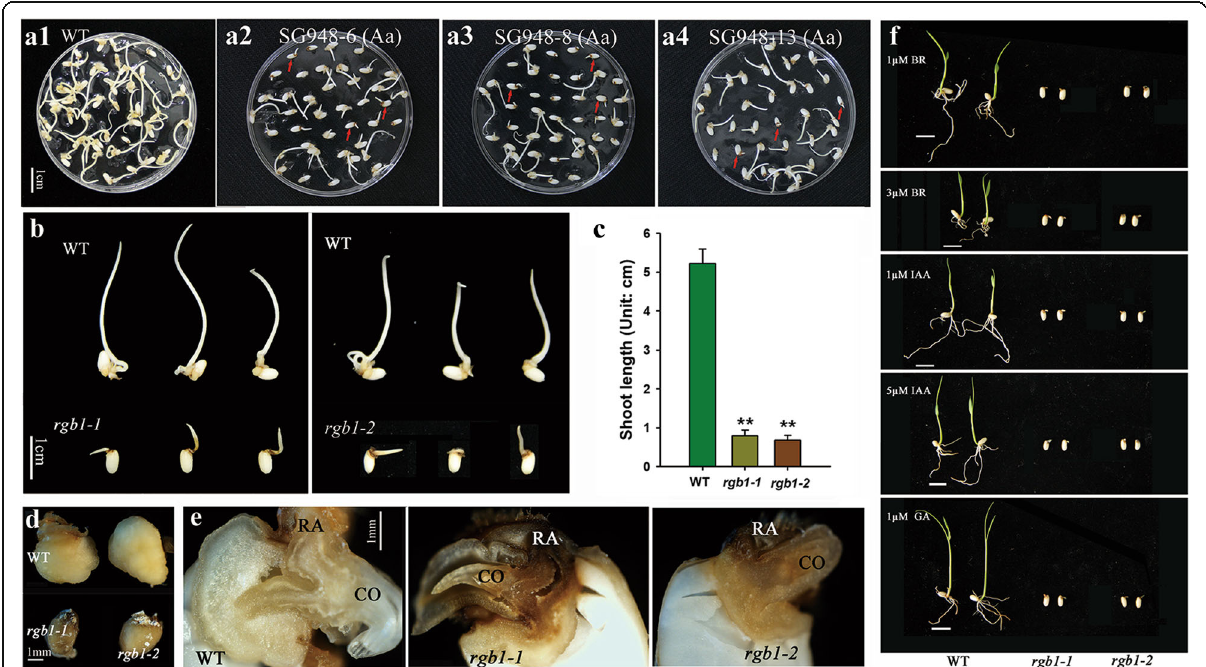
Fig. 3 Callus induction from the mature seeds after 10 days and the different hormone treatments of rgb1 mutants, RGB1 heterozygous mutants, and WT. (a) Mature seeds of the RGB1 heterozygous mutant lines and WT cultured on callus preinduction media (N6D2). (a1) WT control, (a2) SG948 – 6 (Aa), (a3) SG948 – 8 (Aa), (a4) SG948 – 13 (Aa) (Aa indicates heterozygous RGB1/rgb1 mutants). (b) Calli induced from the rgb1 – 1 and rgb1 – 2 mutants compared with WT. (c) Statistical analysis of shoot lengths of the WT and the rgb1 mutants shown in (b) . The data are the means ± SDs ( n = 10; ** p < 0.01). (d) Comparison of the morphology of calli from the WT and the rgb1 mutants. (e) Median longitudinally dissected embryos of WT and rgb1 mutants (CO, coleoptile; RA, radicle). (f) Phenotypic observations of 1-week-old seedlings of the rgb1 mutants and